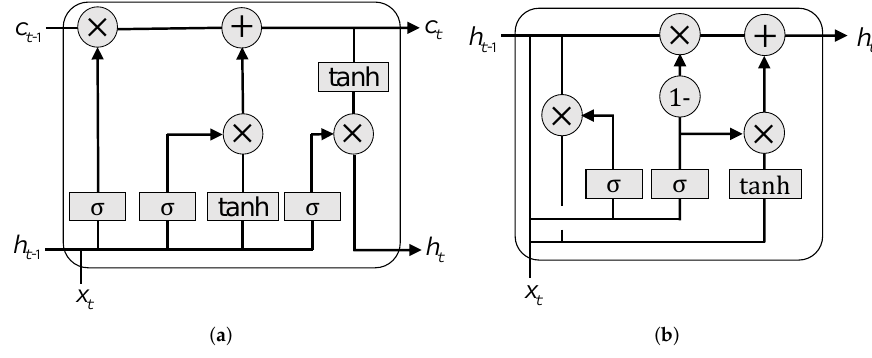
Figure 3. The LSTM and GRU cells. ( a ) LSTM; ( b )